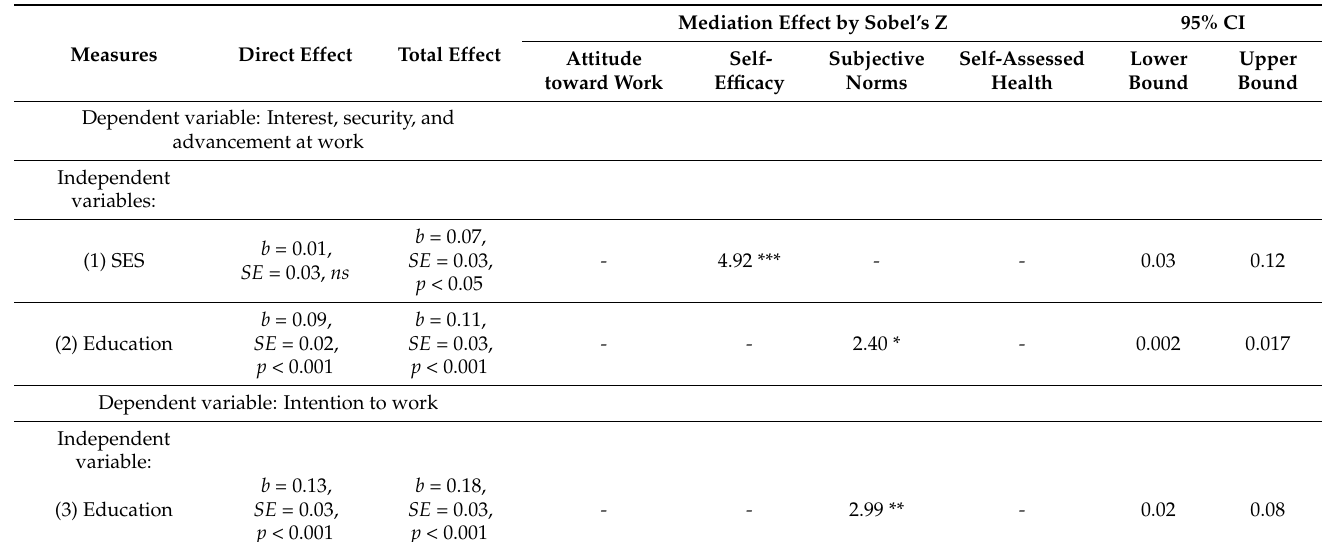
Table 4. The mediation effects of attitude toward work, self-efficacy, and subjective norms on the three outcome variables.